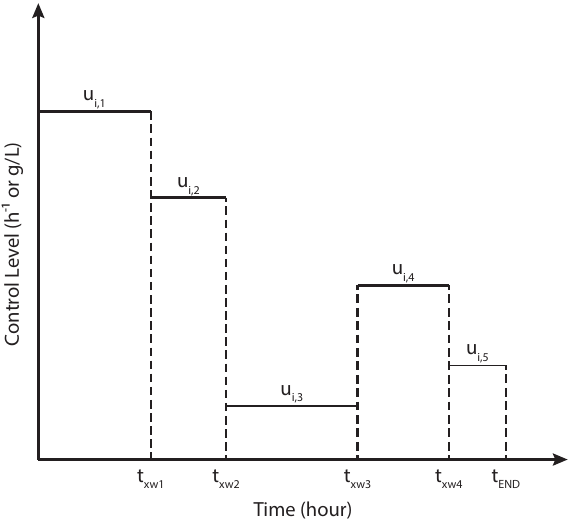
Figure 2. Control vector parametrization of input profiles. In the baker yeast case